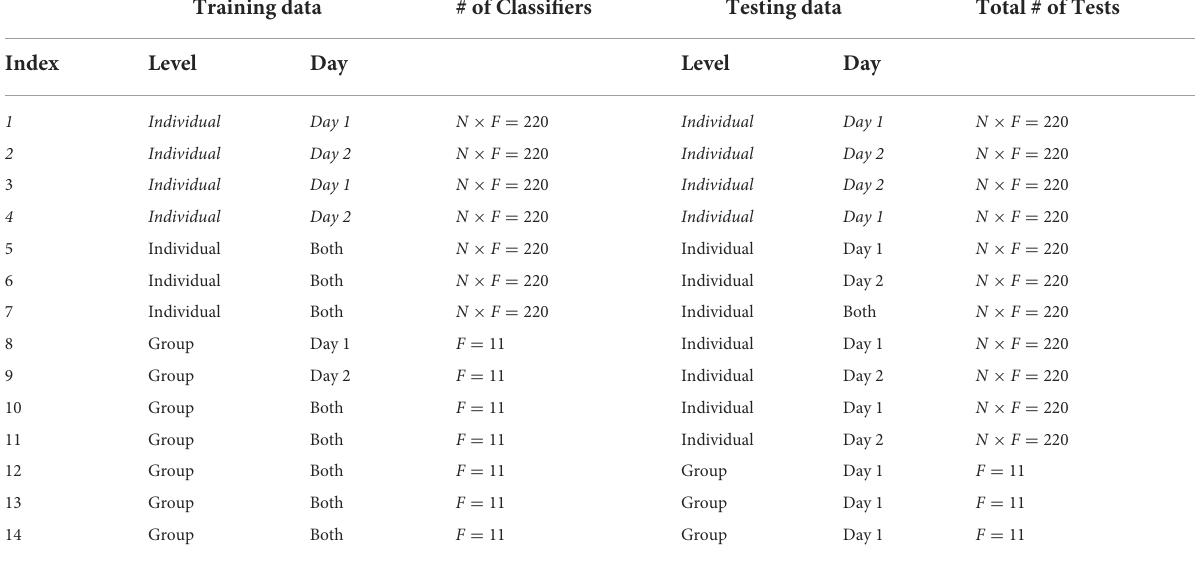
TABLE 6 A systematic way to test the generalizability of classification